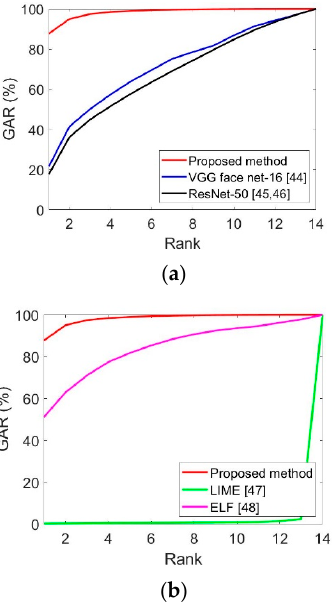
Figure 17. ROC curves acquired using the proposed method and the previous methods. ( a ) Results for face recognition, and ( b ) results for body and face recognition.